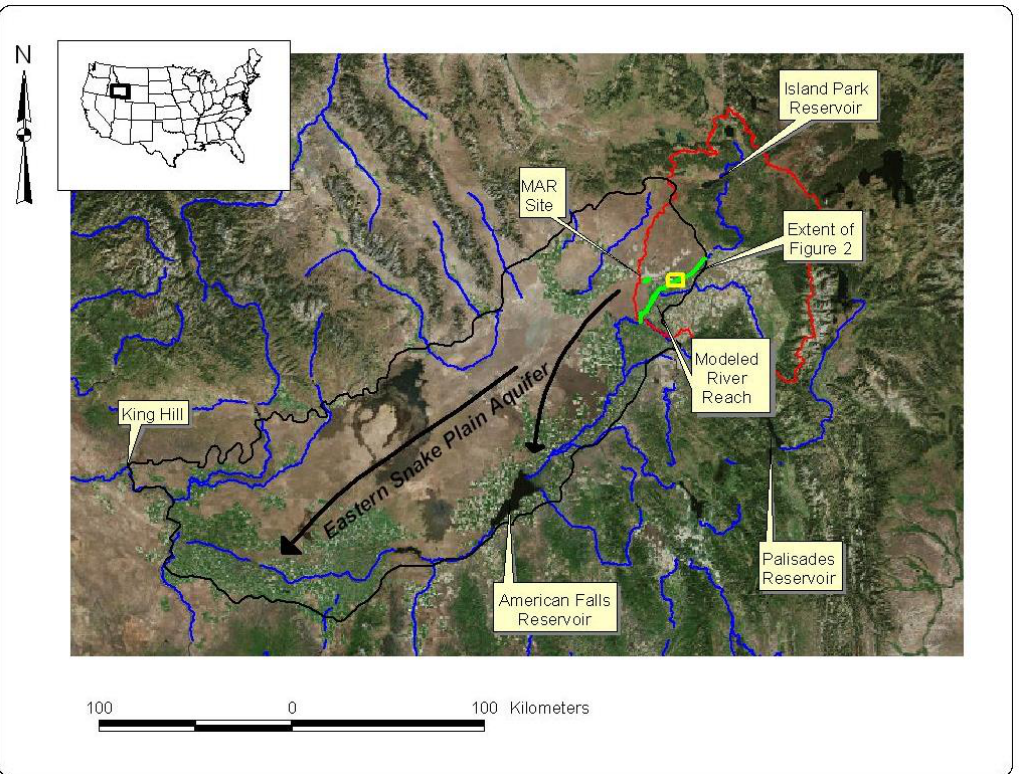
Figure 1. Upper Snake River basin, USA, showing the ESPA, modeled river reach of Henry ’ s Fork (in green), and a nearby MAR site. The red polygon delineates the Henry ’ s Fork watershed, and the yellow rectangle shows the area enlarged in Figure 2. Black arrows indicate primary groundwater flow paths on the ESPA. Data credit: Idaho Department of Water Resources.